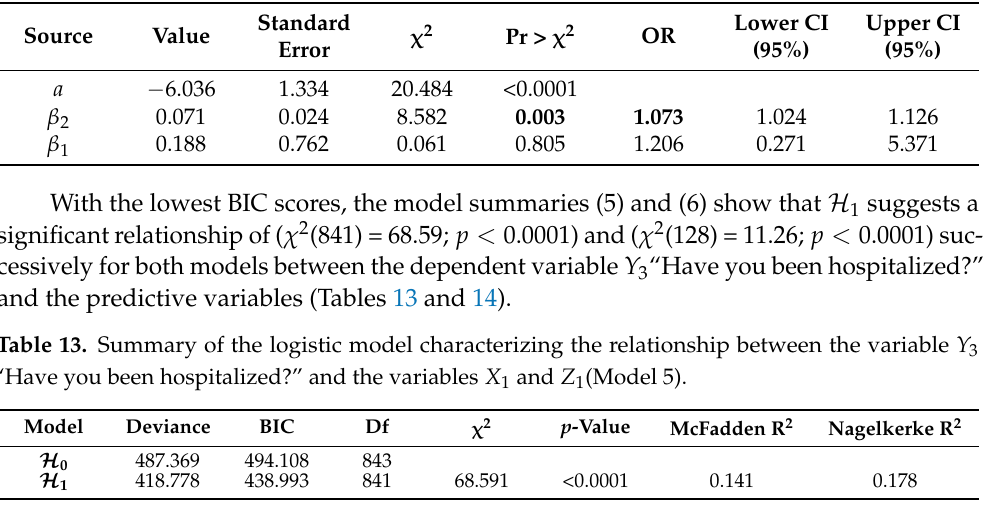
Table 12. The parameters of the logistic model characterizing the relationship between the variable Y 3 “Have you been hospitalized?” and the variables X 1 and Z 1 (Model 6). Bold values indicate a statistically significant impact.